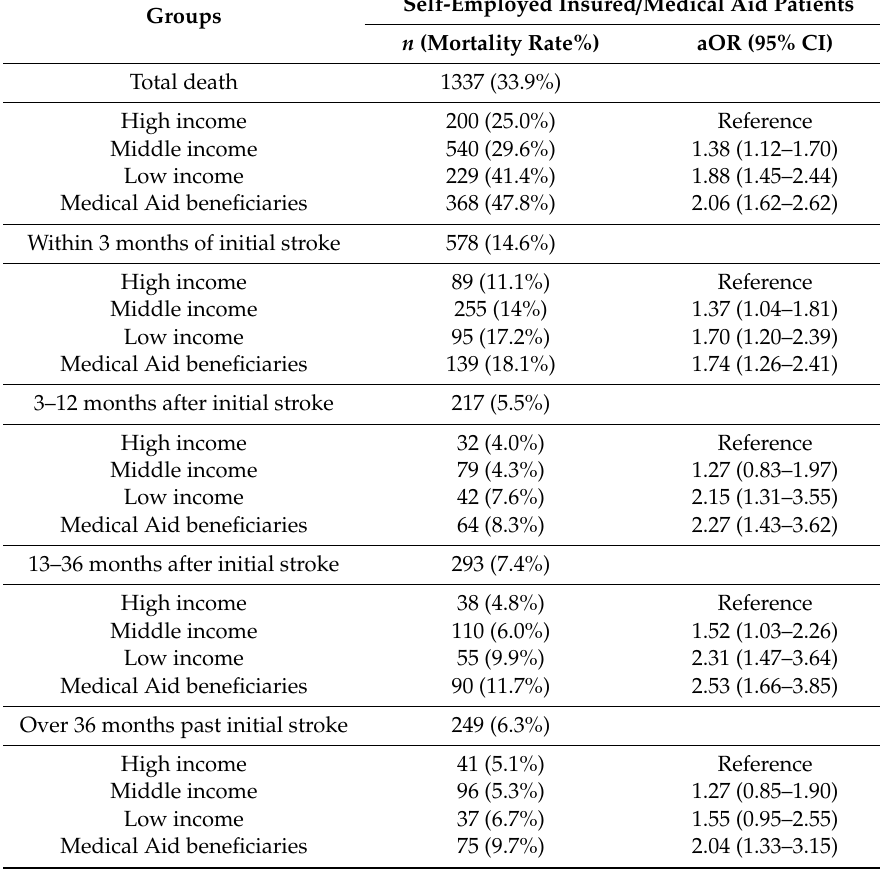
Table 3. Results of Multinomial Logistic Regression for Self-employed Insured / Medical Aid